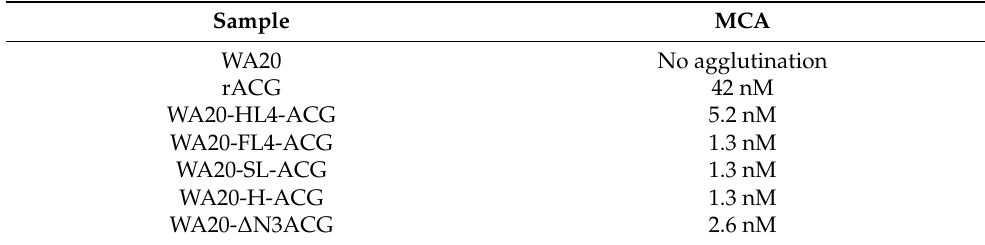
Figure 4. Rigid-body models of the lectin nano-block oligomers of WA20-SL-ACG. The rigid-body models of ( A ) dimer, ( B ) tetramer, and ( C ) hexamer of WA20-SL-ACG. The models were constructed based on the crystal structures of WA20 (PDB ID: 3VJF) [9] and ACG (PDB ID: 1WW7) [30] using the SAXS data and the rigid-body modelling program CORAL [39] without a symmetry constraint. Table 3. MCA of the lectin